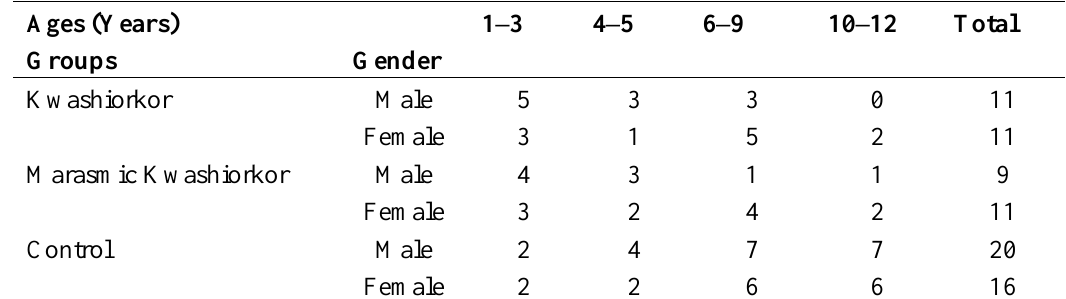
Table 3. Age and sex distribution of control and malnourished children.